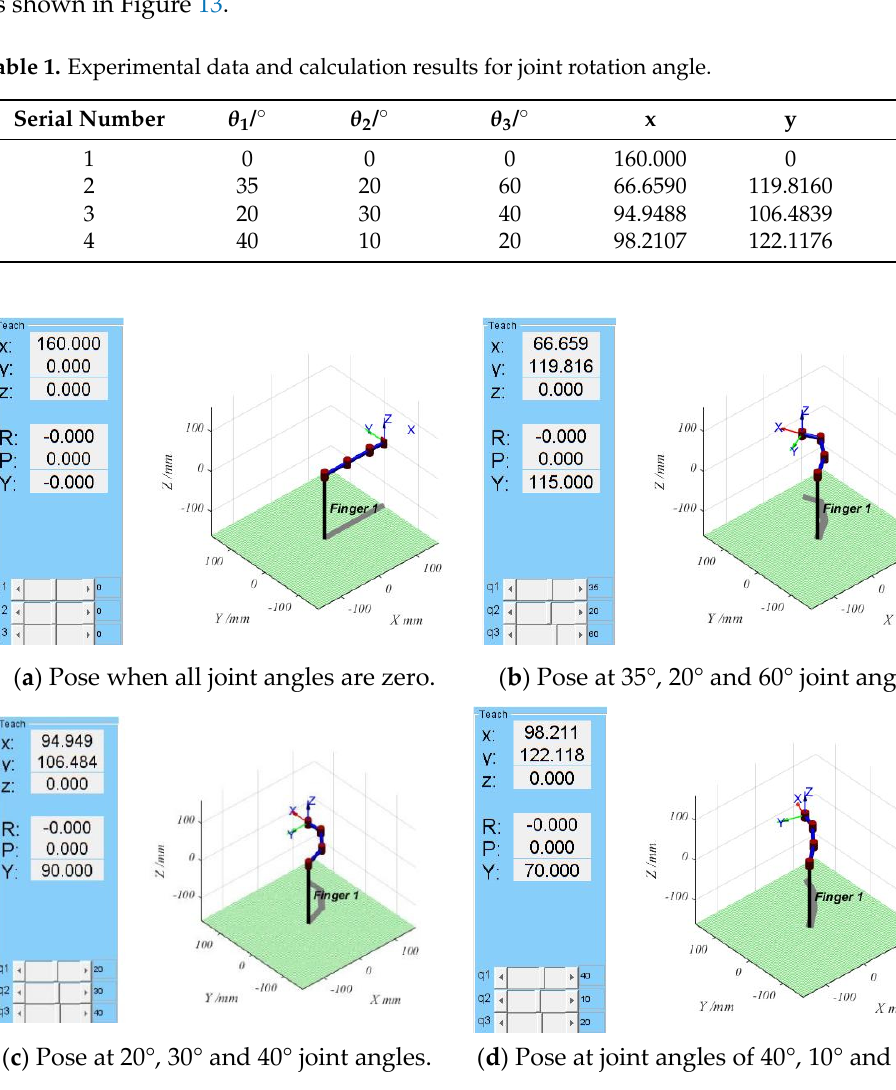
Table 2. Inverse kinematic veri fi cation data